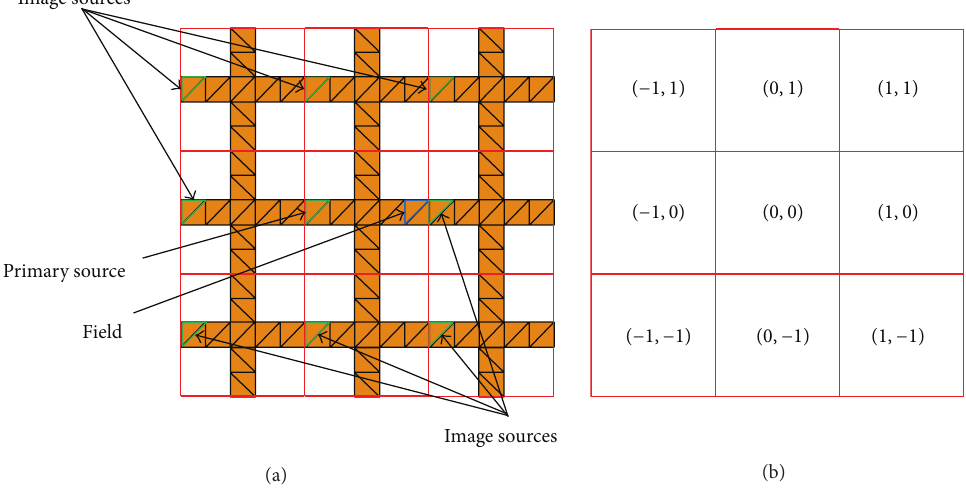
Figure 2: (a) Periodic image sources in triangular boundary mesh. (b) Corresponding lattice numbers. ( 0 , 0 ) lattice is the primary unit